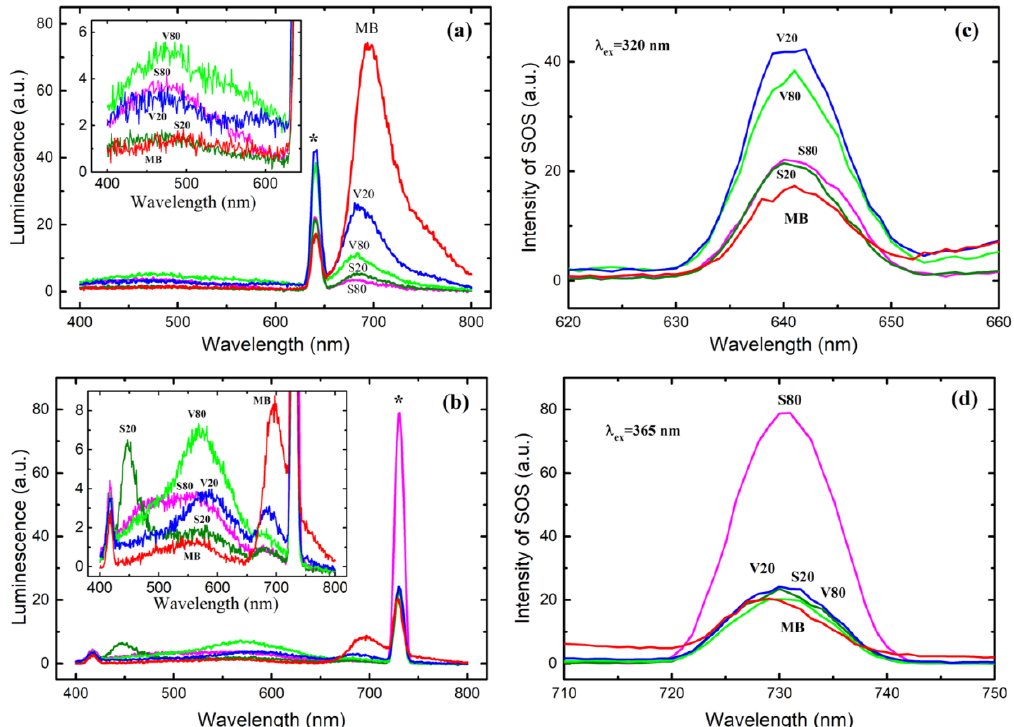
Figure 5. Luminescence spectra upon excitation at wavelengths of 320 nm ( a ) and 365 nm ( b ) of MB aqueous solutions (10 mg·L −1 ) after illumination with visible (V) light and sunlight (S) at 20 °C and 80 °C for 120 min. Asterisks mark second-order scattering. The insets show magnified parts of the spectra. The enlarged second-order scattering peaks are ( c ) and ( d ).